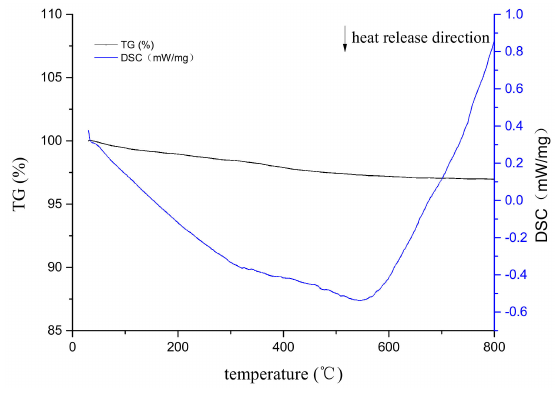
Figure 5. Differential scanning calorimetry and thermogravimetric curve of oolitic